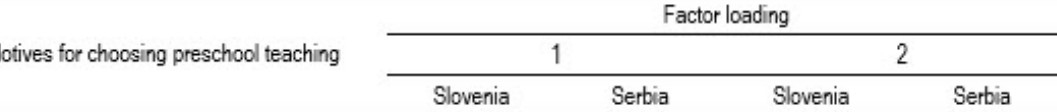
Results from a factor analysis of the Motives for Choosing Preschool Teaching